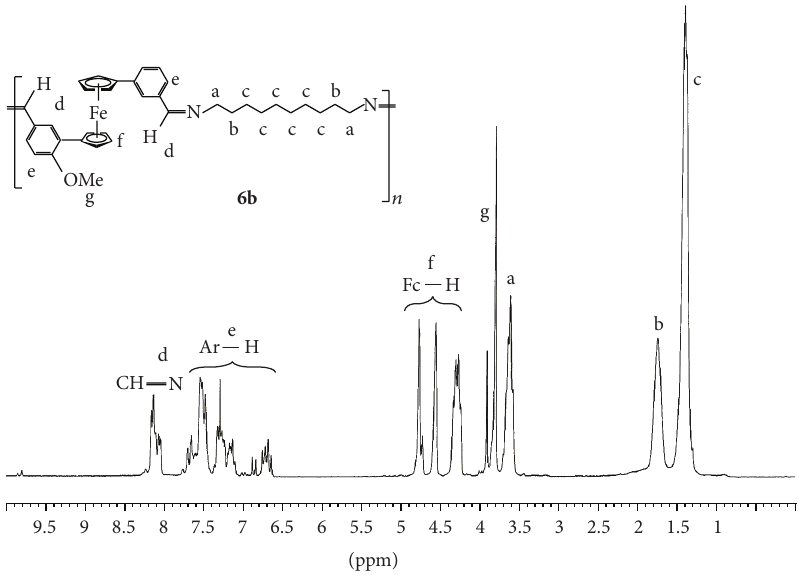
Figure 2: H-NMR spectrum of Fc-polyazomethine 6b in CDCl 1